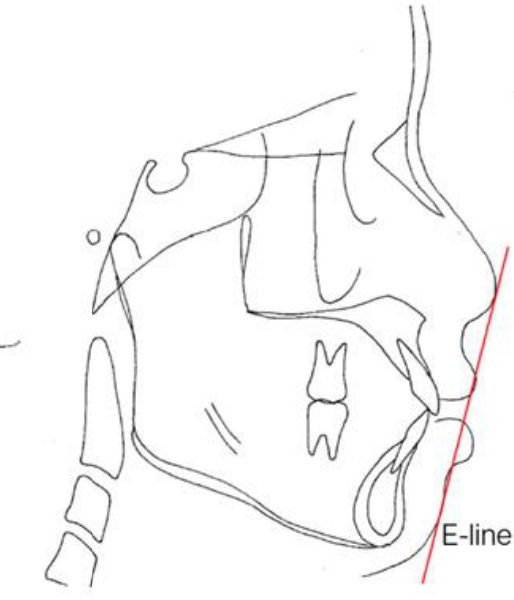
Figure 7. Esthetic line (E-line). The line drawn from the tip of the nose to tip of the chin.